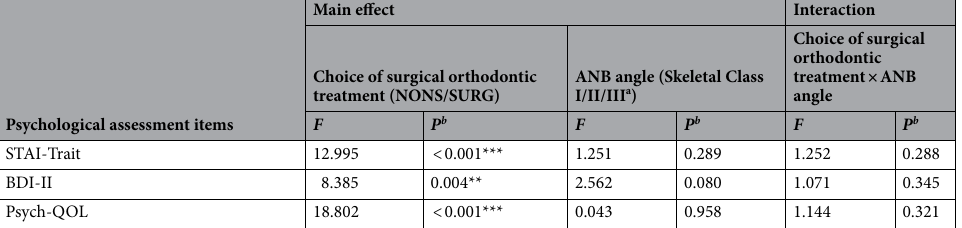
Table 3. Results of linear mixed-effects model of psychological evaluation scores. NONS non-surgical orthodontic treatment, SURG surgical orthodontic treatment, ANB angle anterior–posterior skeletal pattern classification by ANB angle, STAI State-Trait Anxiety Inventory, BDI-II Beck Depression Inventory-II, Psych- QOL psychological domain of the World Health Organization Quality of Life 26. a Skeletal Class I (Japanese normal mean value - 1 SD ≤ ANB angle ≤ Japanese normal mean value + 1 SD), Class II (ANB angle > Japanese normal mean value + 1 SD), and Class III (ANB angle < Japanese normal mean value - 1 SD). b Linear mixed- effects model. ** P < 0.01; *** P <